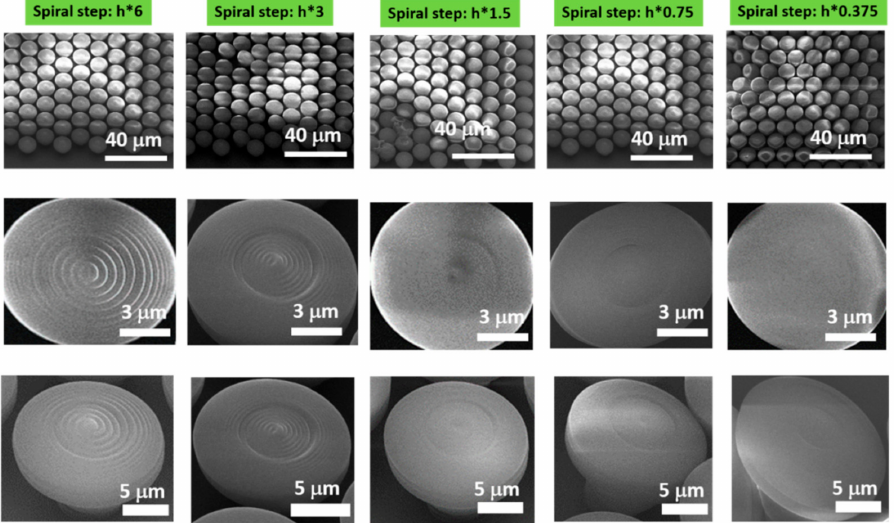
Figure 3. Scanning electron micrographs (SEM) of nanostructured mushroom-like pillars (NMPs), fabricated by LDW via TPP of IP-Dip photopolymer. The original spiral step (h) was multiplied with coefficients indicated above each figure: ( Upper panel ) Tilted top views of NMPs arrays (tilted at 30 degrees); ( Middle panel ) Close top views of single NMP; ( Lower panel ) Tilted top views of single NMP (tilted at 30 degrees). Writing parameters: 12.5 mW laser power and 100 µ m/s scanning speed. The spiral step, h, represents the height difference of the laser focus after completing a 360-degree trip while writing the